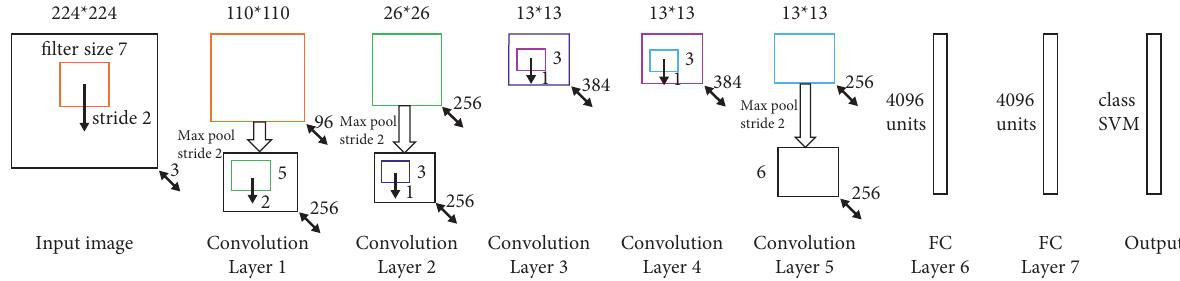
Figure 3: The typical structure of